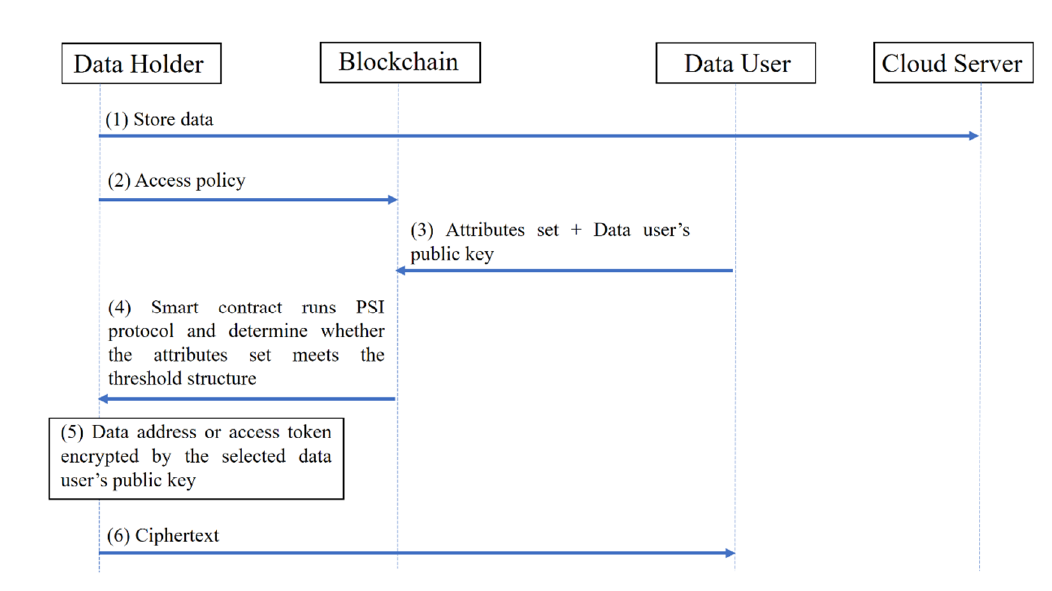
Figure 1. System Figure 1. System Model.